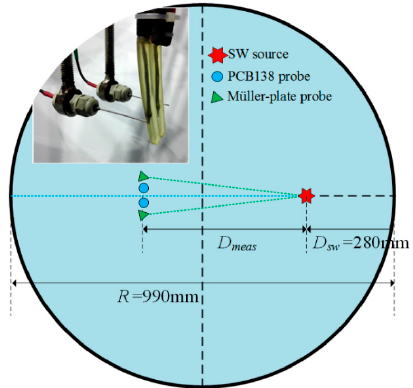
Figure 3. Pressure probes arrangements in the water tank.